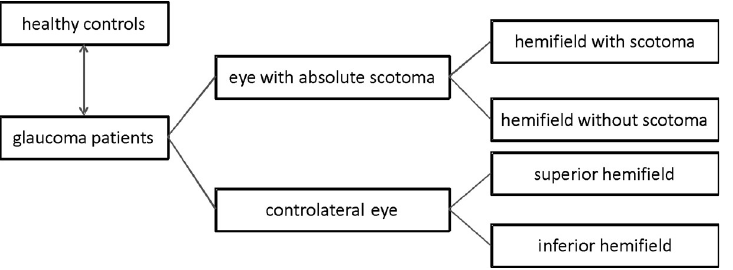
Fig 1. Grouping of patients, eyes and hemifields included into the analyses. Presentation of grouping for analysis of macular retinal layers in glaucoma eyes and healthy